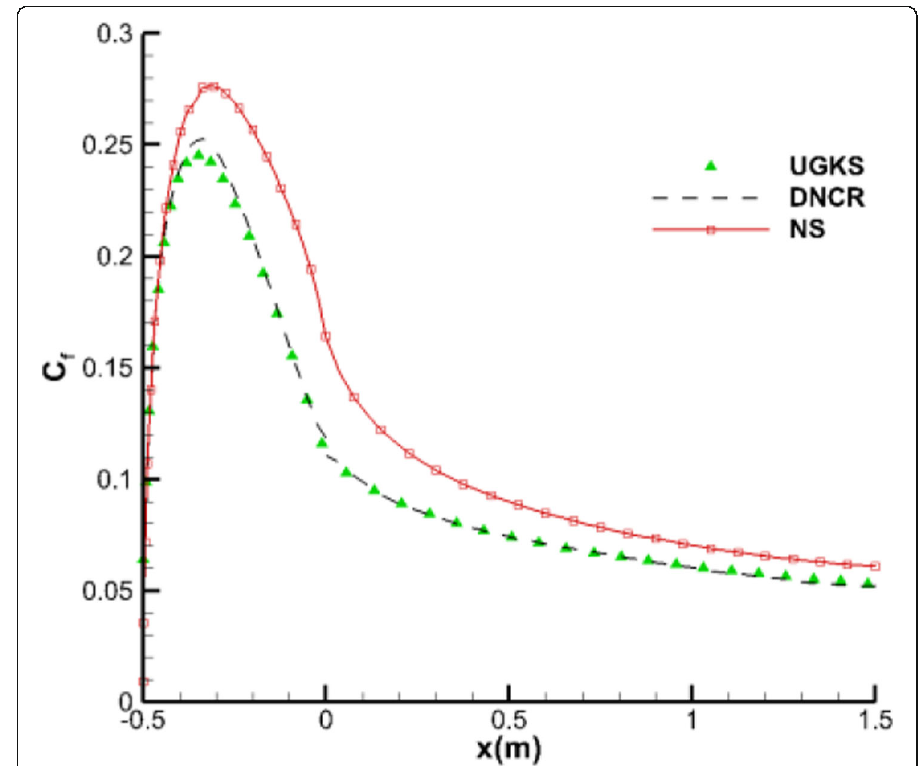
Fig. 15 Shear stress coefficient distribution along the upper surface